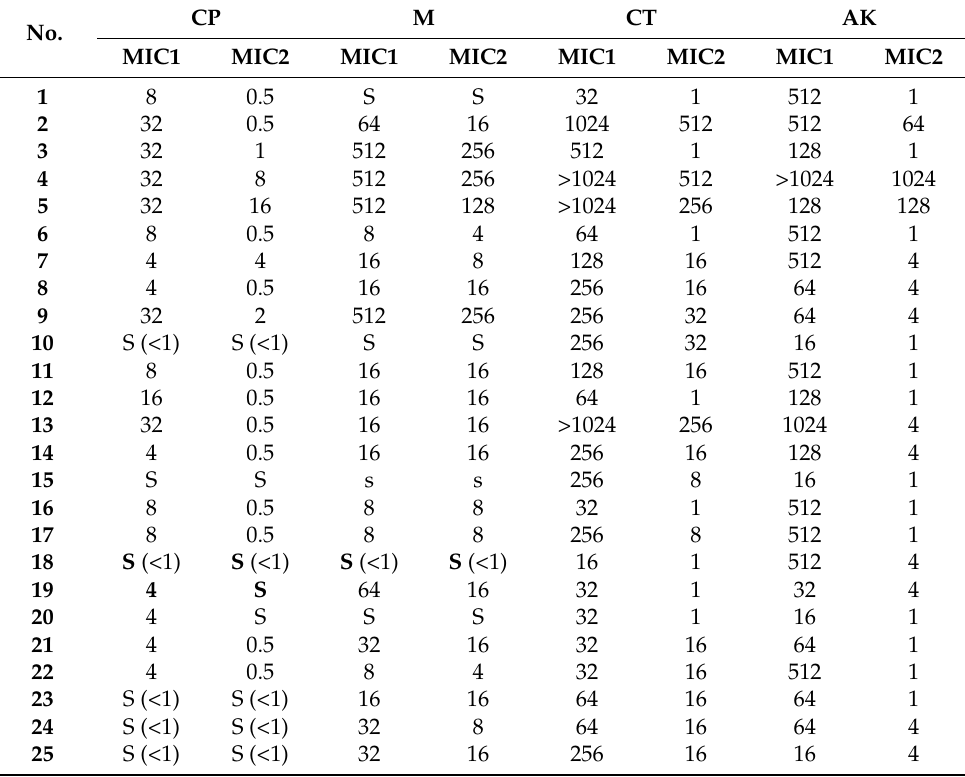
Table 4. Effect of the addition of TDN on MICs of the tested antibiotics.